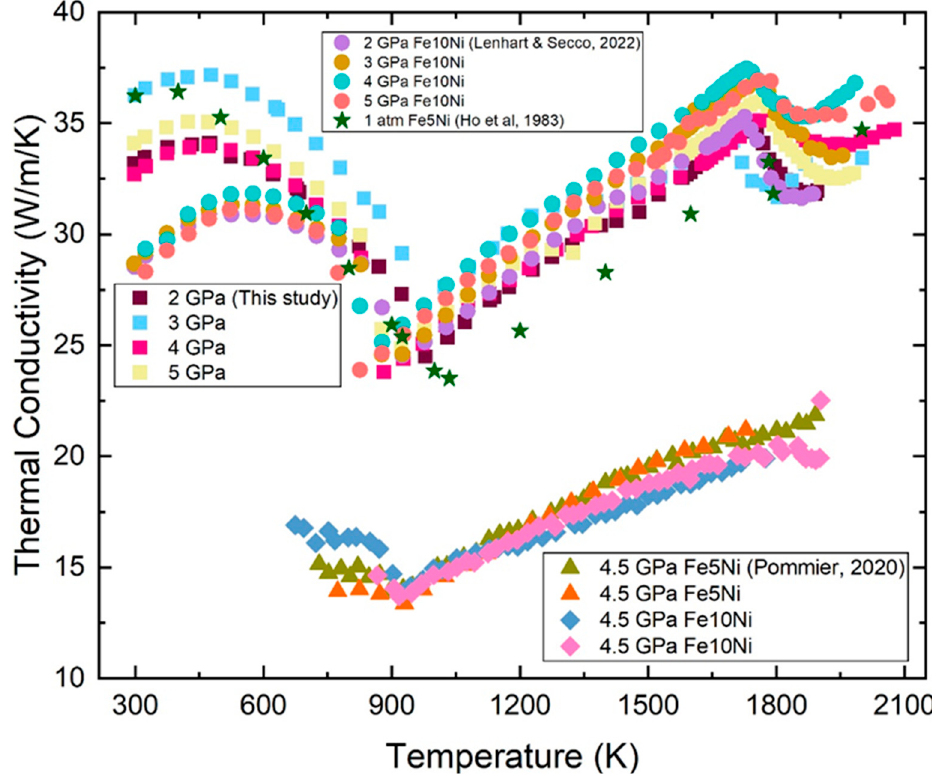
Figure 5. Comparison of thermal conductivity of Fe-5 wt% Ni and Fe-10 wt% Ni [17,27,28].